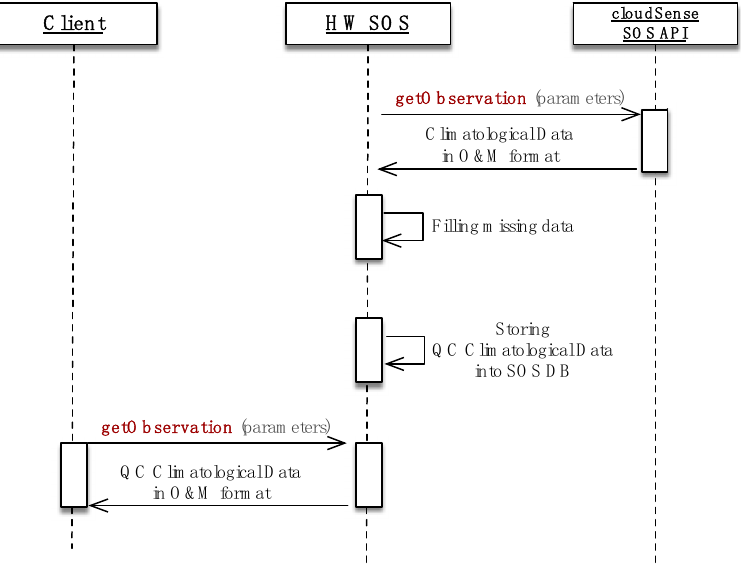
Figure 5. Sequence diagram presents climatological data acquisition and provision of HW SOS.